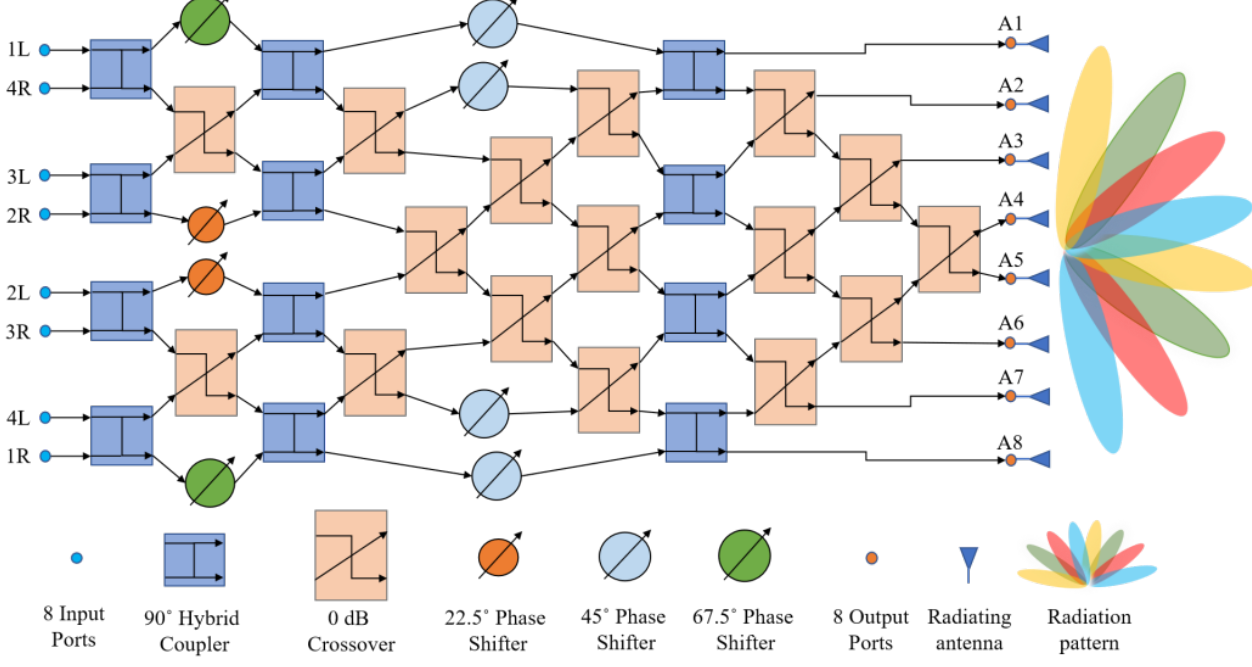
Figure 4. Operational block diagram of an 8 × 8 Butler matrix.